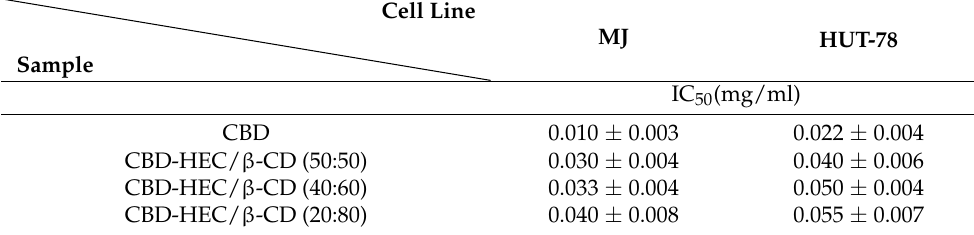
Figure 8 . Concentration–response curves for two human tumor cell lines -MJ (A) and HUT-78 (B), determined by the MTT assay after 72 hours of continuous exposure. Each data point represents an average arithmetic value ± standard deviation of 8 independent experiments. Table 1. Equieffective concentrations (IC 50 ) of free and loaded CBD.